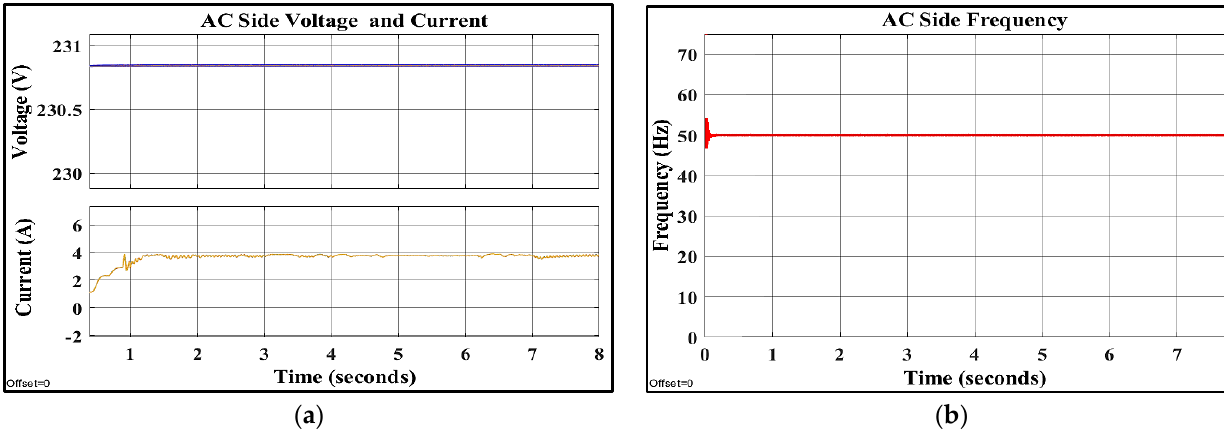
Figure 12. 3Ph AC bus RMS current and voltage in ( a ) and frequency in ( b ) under first Scenario 1.